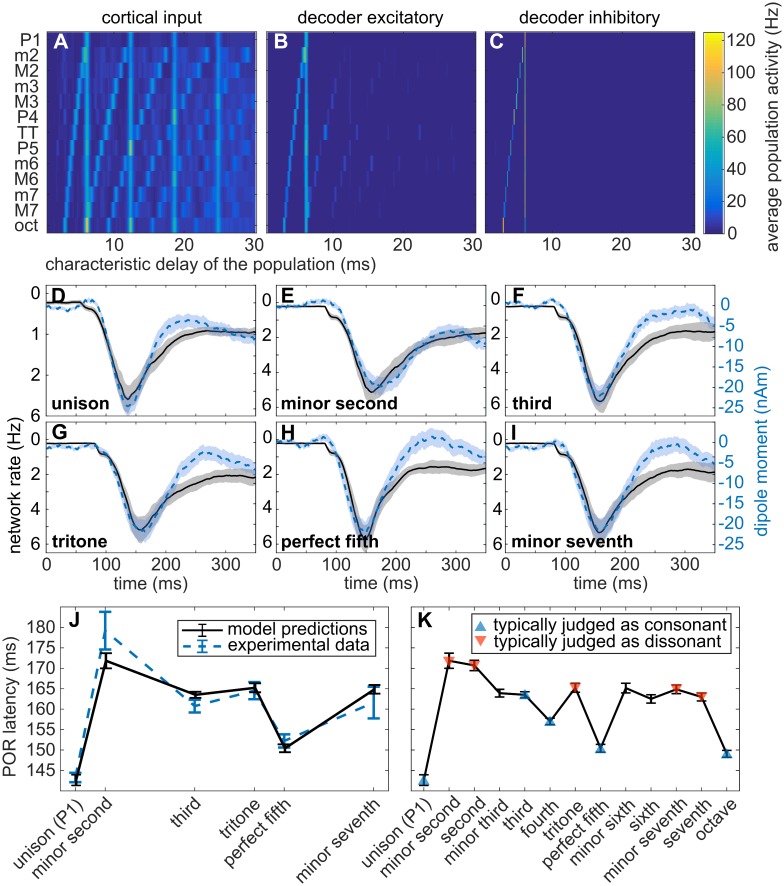
Model responses to the IRN dyads.(A–C) Neural representation of the dyads at different stages of the model: (A) periodicity detectors, (B/C) excitatory/inhibitory ensembles in the decoder network; each row shows the activity elicited by each dyad. Excitatory and inhibitory ensembles in the sustainer are precisely correlated with the decoder-inhibitory heatmap. (D–I) Examples of the collective excitatory activity in the decoder network (monotonically related to the equivalent dipole moment elicited by the network) in comparison with the elicited dipole moment measured during the experimentation in the neural generator of the POR. The scale of the field derived for the unison dyad was adjusted to account for the comparatively smaller effect on the network of the unison input, which effectively activates half of the populations than the other dyads. (J) Latency predictions for IRN dyads compared with the experimental results reported in the previous section. (K) Latency predictions for all dyads in the chromatic scale. Consonant dyads are represented with a green triangle, whilst strongly dissonant dyads are represented with a red triangle; dissonance was assessed according to Helmholtz [6] (see table in Fig 61 of the original text). Model predictions were averaged across N = 60 runs, error bars and shaded contours are standard errors. Blue shaded contours correspond to the experimental observations; grey shaded contours correspond to the model simulations.